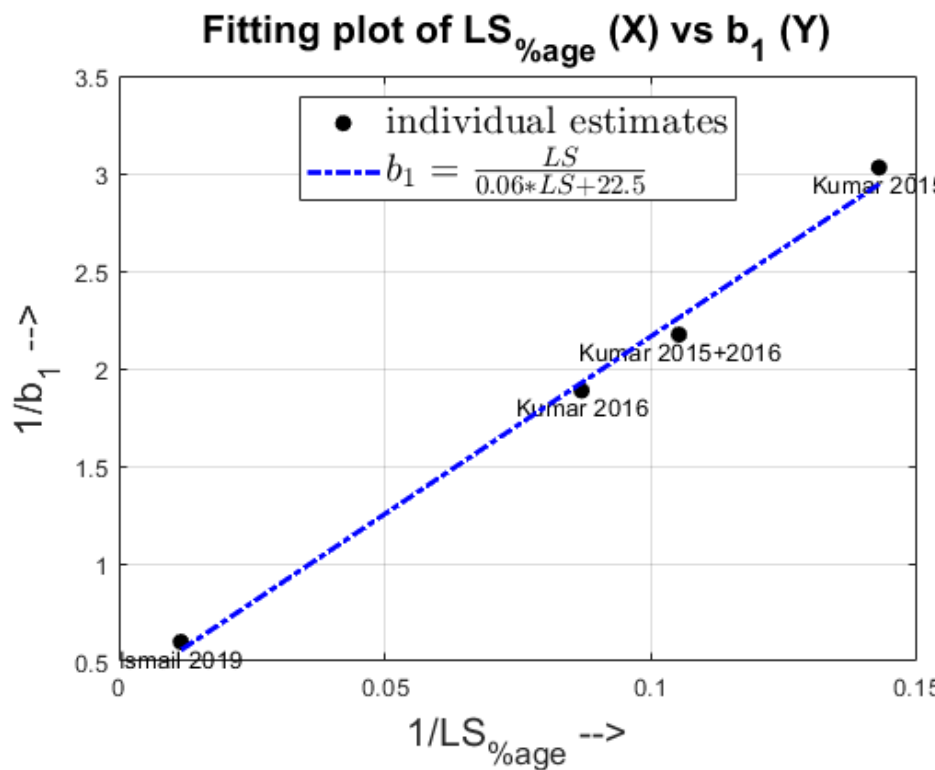
Figure 12. Fitting trend of b 1 for different datasets as the LS percentage is